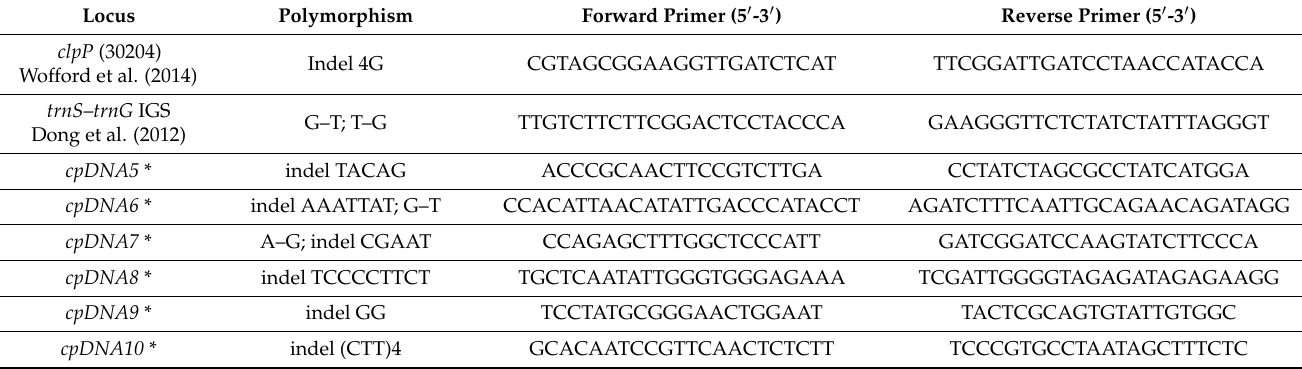
Table 1. Candidate microsatellite primers tested for high-resolution melting